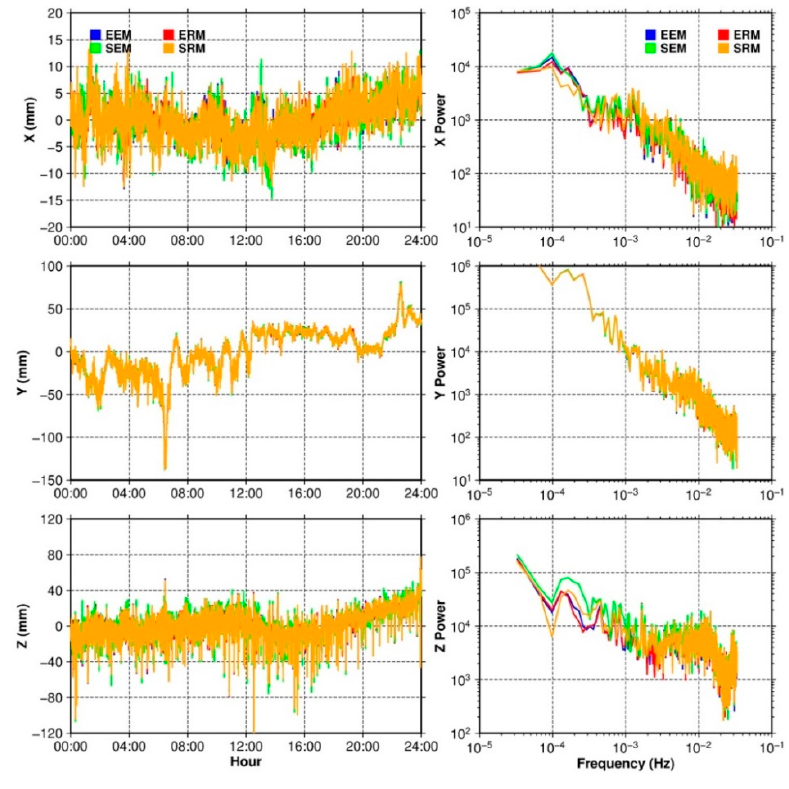
Figure 17. Deformation monitoring time series of SHM2.